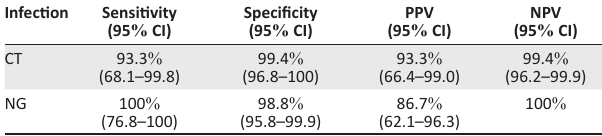
TABLE 3: Diagnostic characteristics of the Presto assay National Reference Laboratory, Kigali, Rwanda, May 2013 – March